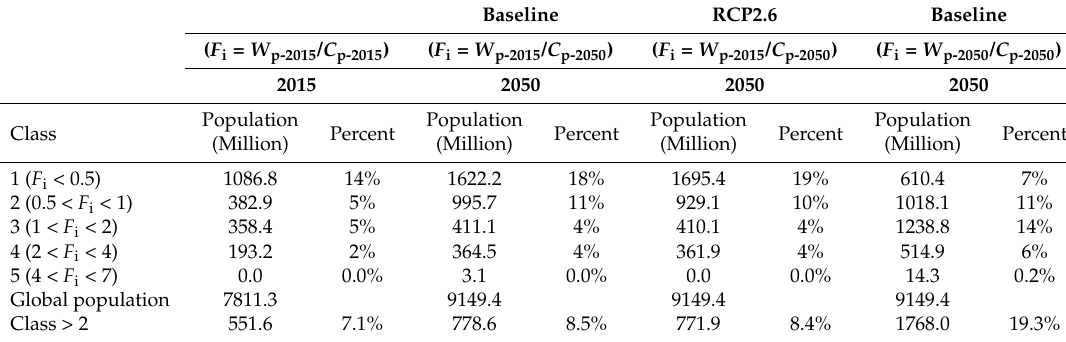
Figure 5. Global distributions of the desalination population in each “country with the potential to develop seawater desalination” (CDSD) in different years and under different projection conditions. The values in ( a – d ) show the ratio of the total global desalination populations in all CDSDs to the global population. Table 2. Total global desalination population and percentages of global population in each feasibility index class in different years and under different projection conditions.